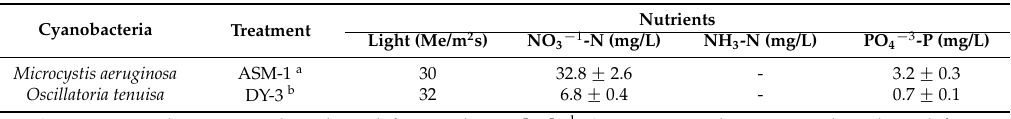
Table 1. Concentrations of media nutrient during growth of cyanobacteria at 25 ˝